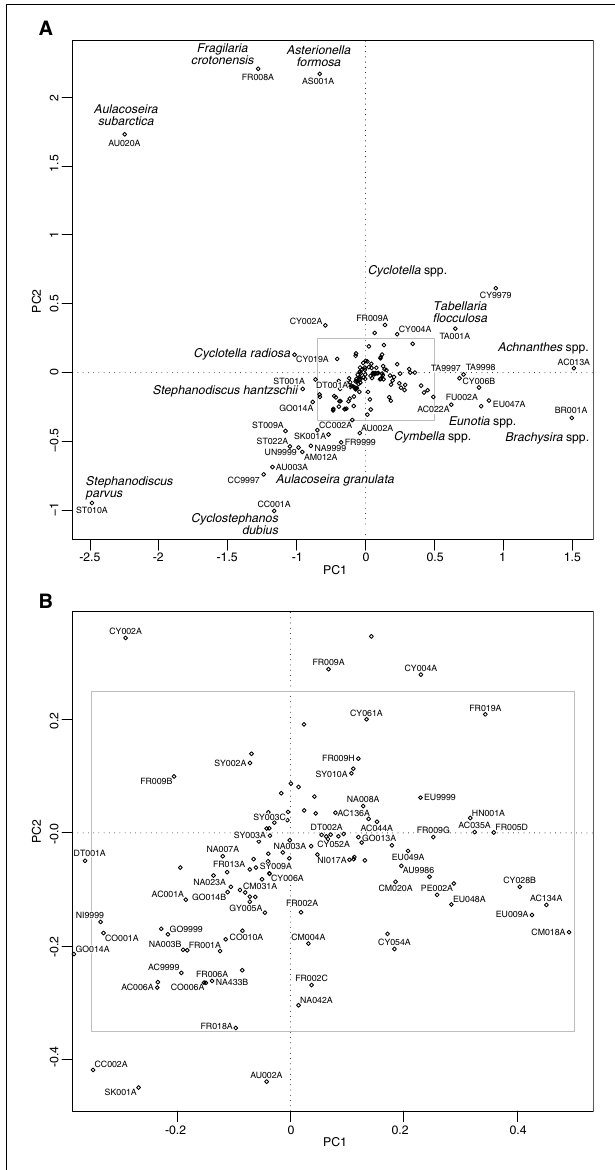
FIGURE 7 | Species plot on a PCA of training set samples for the deep lake cores. (A) All taxa present in at least two sites and with maximum abundance greater than or equal to 2%, (B) zoomed in section as indicated by the inset in (A) . See Supplementary Material, Appendix 1 for diatom codes and